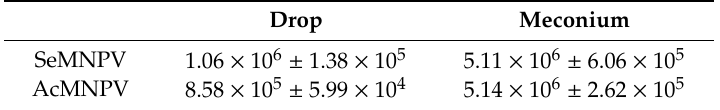
Table 1. Presence of occlusion bodies (OBs) in Chrysoperla carnea excretion